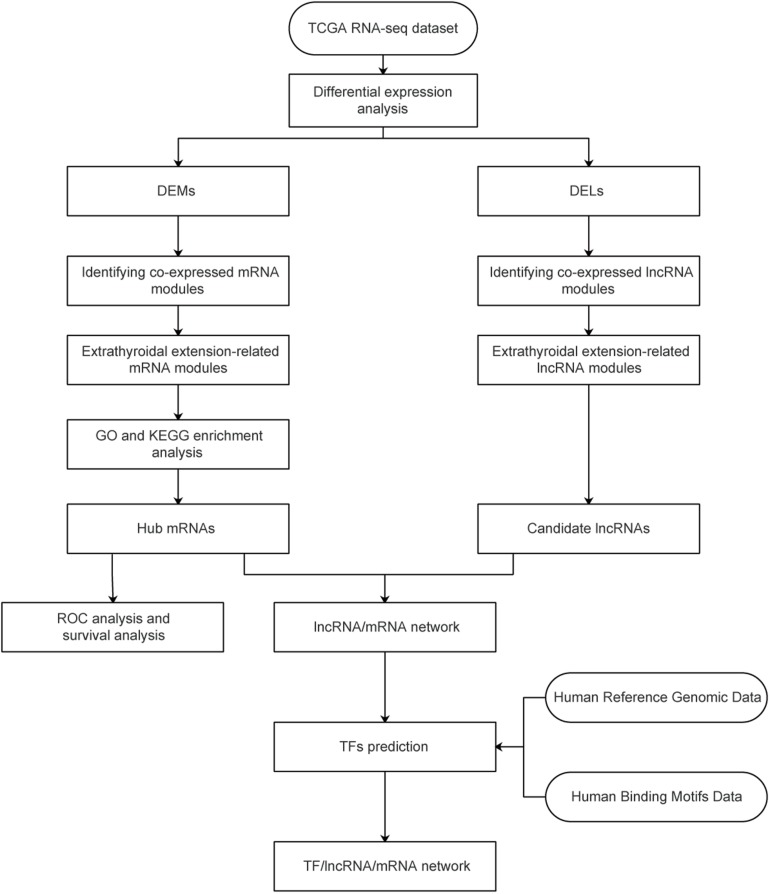
Study flowchart. TCGA, The Cancer Genome Atlas; GO, gene ontology; DEG, differentially expressed gene; DEL, differentially expressed lncRNA.